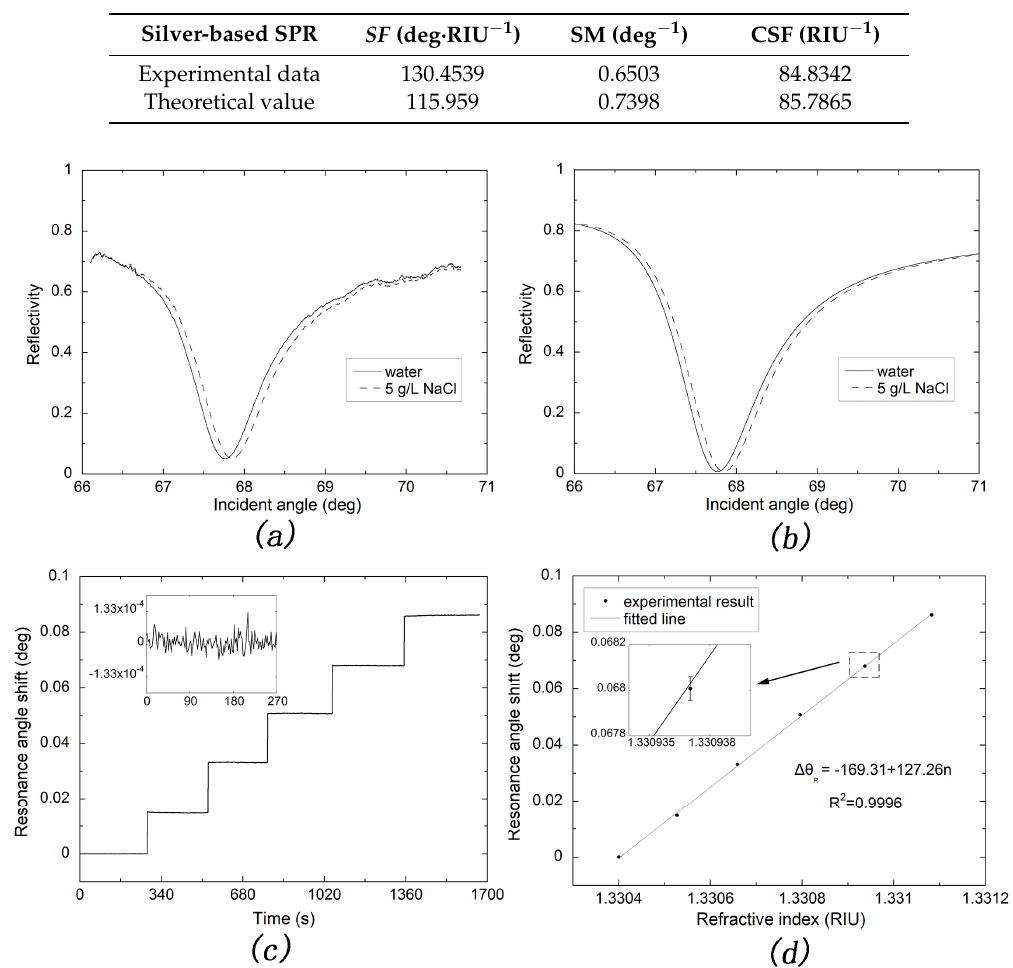
Figure 6. ( a ) Angular spectrum of silver-based SPR sensor measured with water and 5 g/L NaCl solution; ( b ) Angular spectrum of silver-based SPR sensor calculated with water and 5 g/L NaCl solution; ( c ) Resonance angle shift plotted against the experiment time for NaCl solutions (0, 1, 2, 3, 4, 5 g/L ); ( d ) Linear fitting of experiment result from ( c ). Error bars indicate the standard deviations.